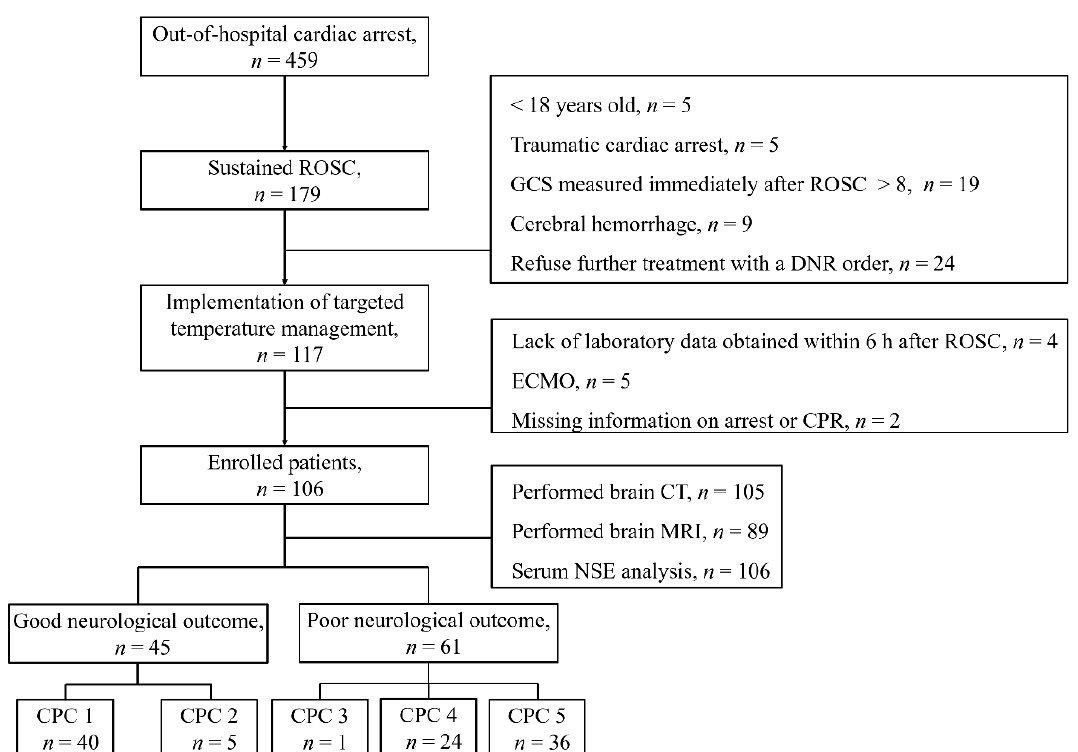
Figure 1. Flow diagram showing the selection of study patients.